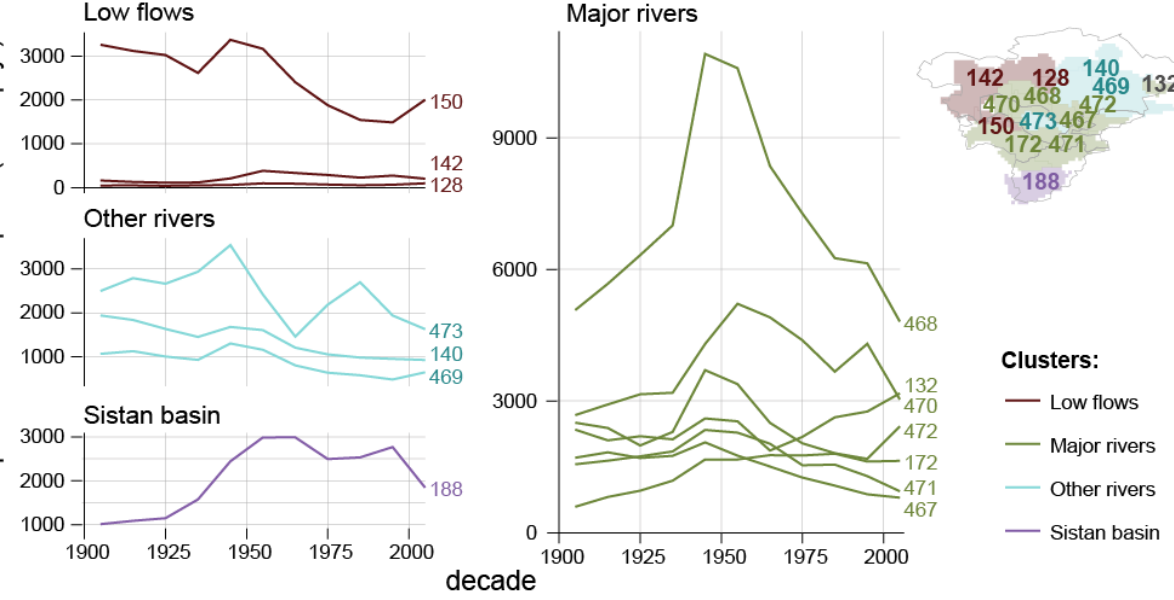
Figure 4. Human blue water consumption per